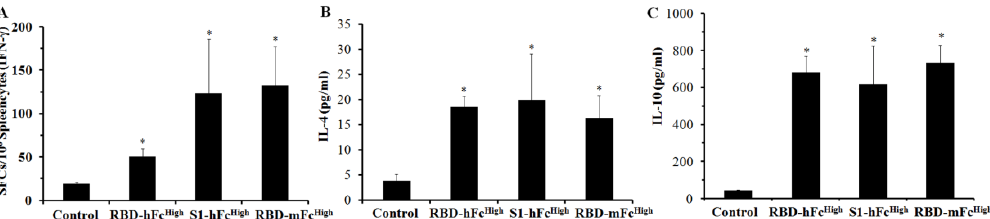
Figure 4. Cellular immune response of recombinant RBD and S1 subunit vaccines. Twelve weeks after the boost immunization, the splenocytes isolated from RBD-hFc, RBD-mFc and S1-hFc fusion protein-immunized mice were stimulated with the RBD protein for 16 h. ( A ) ELISPOT was conducted to evaluate the concentration of IFN- γ secreted by splenocytes. ELISA was performed to quantify the release of IL-4 ( B ) and IL-10 ( C ) in the culture medium of splenocytes. * Significant difference compared with the control group ( p < 0.05).